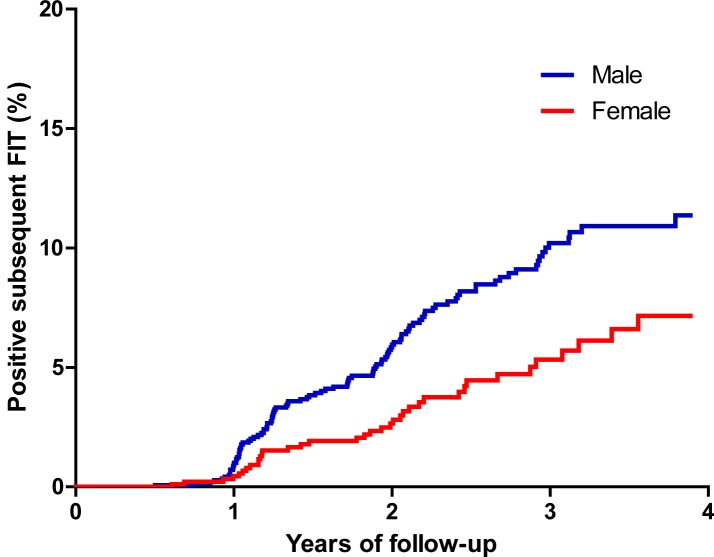
Kaplan-Meier survival analyses for the risk of positive fecal immunochemical tests in the subsequent screening between men and women less than 60 years of age (χ2
log-rank = 9.74, P = 0.002).